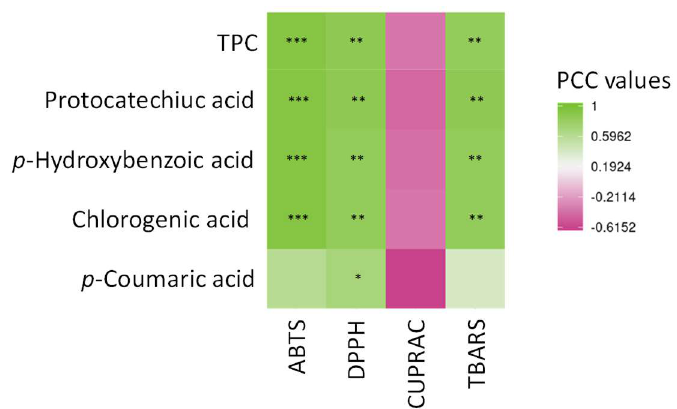
Figure 6. Pearson correlation analysis (PCC) of the relation between the main phytochemicals (protocatechuic acid, p -hydroxybenzoic acid, chlorogenic acid and p -coumaric acid) from AOR extracts obtained after USAE and the di ff erent antioxidant assays (ABTS, DPPH, CUPRAC and TBARS). *** significant p < 0.001; ** significant p < 0.01; * significant p < 0.05; actual PCC values are indicated in Supplementary Materials Table